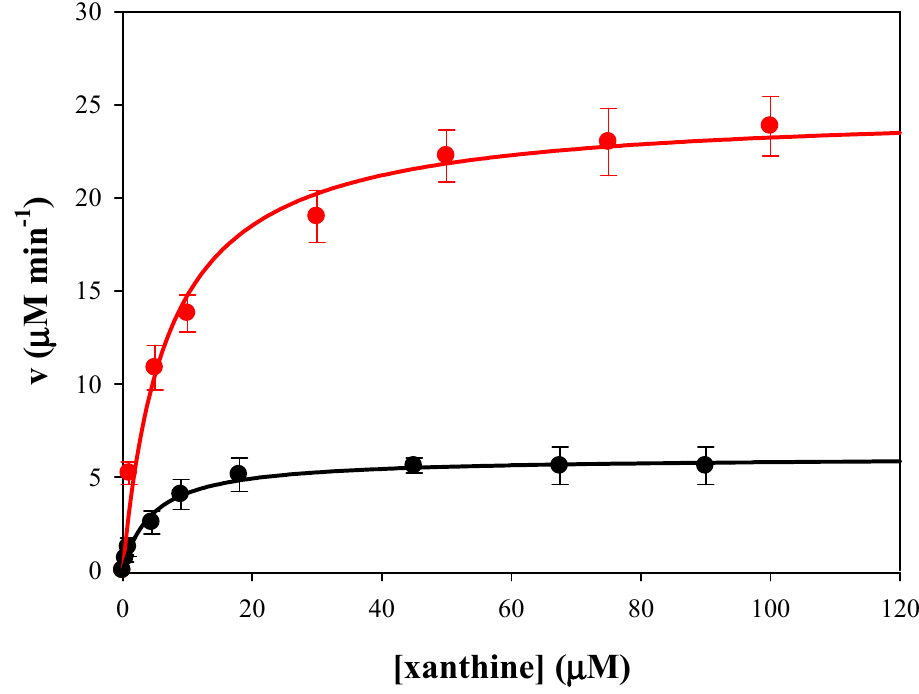
Figure 3. Comparison of enzymatic activity of native (black line) and immobilized Xanthine Oxidase (red line). Measurements were carried out in 50 mM potassium phosphate buffer, pH 7.5, at 25 °C in the presence of 51 nM XO (0.25 mg mL − 1 SAMN@XO, 60 µg XO mg − 1 SAMNs). Table 1. Parameters of the native XO and SAMN@XO